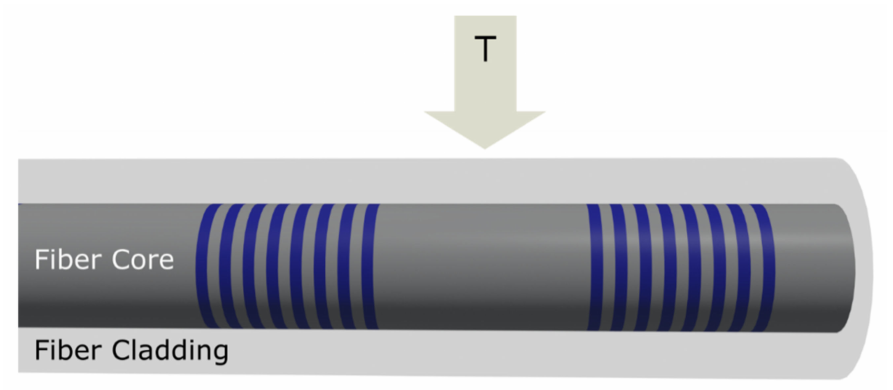
Figure 6. The in-line POF PFI is based on the use of two gratings. The authors obtained three mirrors by using SU-8 photoresists (GM1070) and PDMS at the end of the face of SMF: SMF/SU-8, SU-8/PDMS, and PDMS/air, respectively [93]. Since the light from the source is reflected from the three mirrors, a multimode FPI can be built. Those interfering reflected beams produce a measurement signal whose spectra modulate as the temperature changes. This FPI has a sensitivity of 689.68 pm/ ◦ C and operates in a temperature range of 20 ◦ C–75 ◦ C. Whereas Cao et al. proposed similar construction to and creating three mirrors SMF/air, air/polymer, and polymer/air. The sensor used a broadband source (1200–1700 nm) and offers a measurement range of 20 ◦ C to 55 ◦ C and